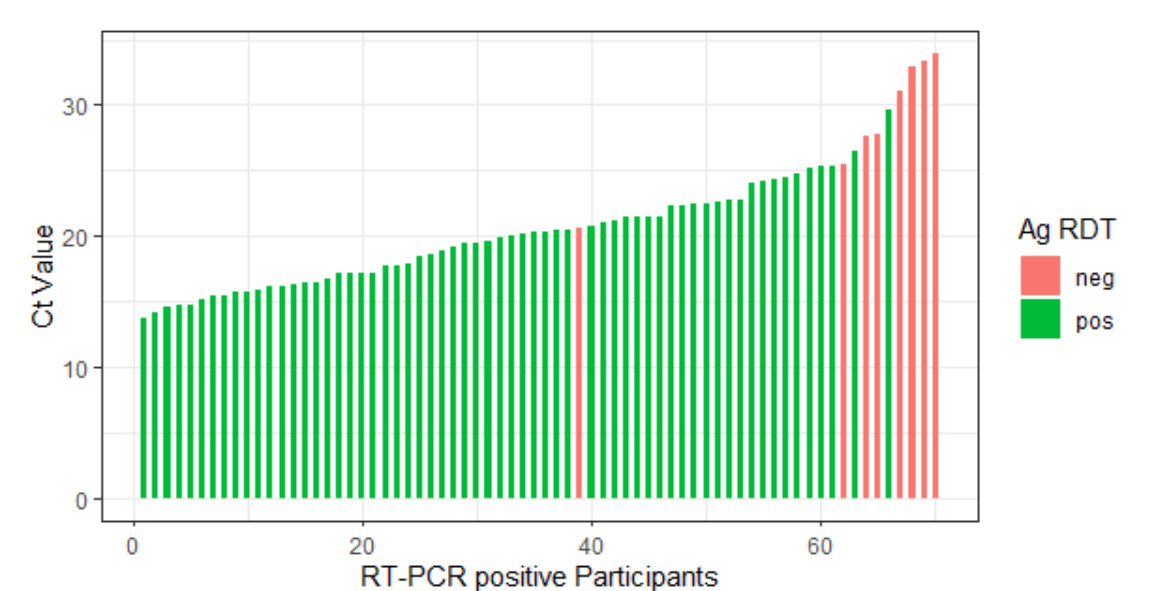
Figure 3. Bar plot showing Ag-RDT results and the corresponding Ct-values of 70 real-time polymerase chain reaction (RT-PCR) positive patients. Ct — Cycle threshold, ag RDT (antigen rapid diagnostic tests), neg — negative, pos — positive.